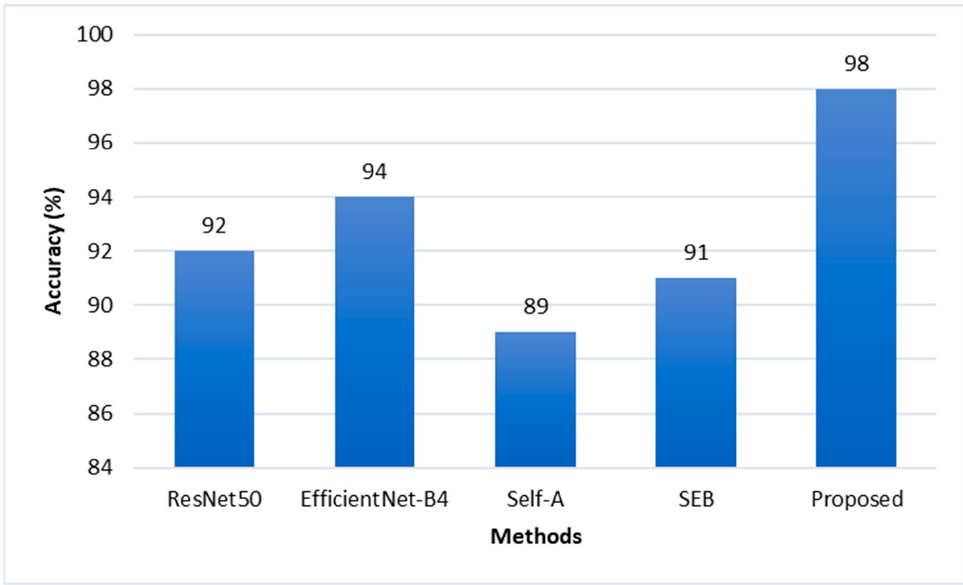
Figure 8. Proposed model performance comparison with existing methods. Squeeze-and-excitation networks (SEB) [40], self-attention generative adversarial networks (Self-A) [41]. networks (SEB) [40], self-attention generative adversarial networks (Self-A) Squeeze-and-excitation block (SEB) [40] squeezes the learned feature maps in order